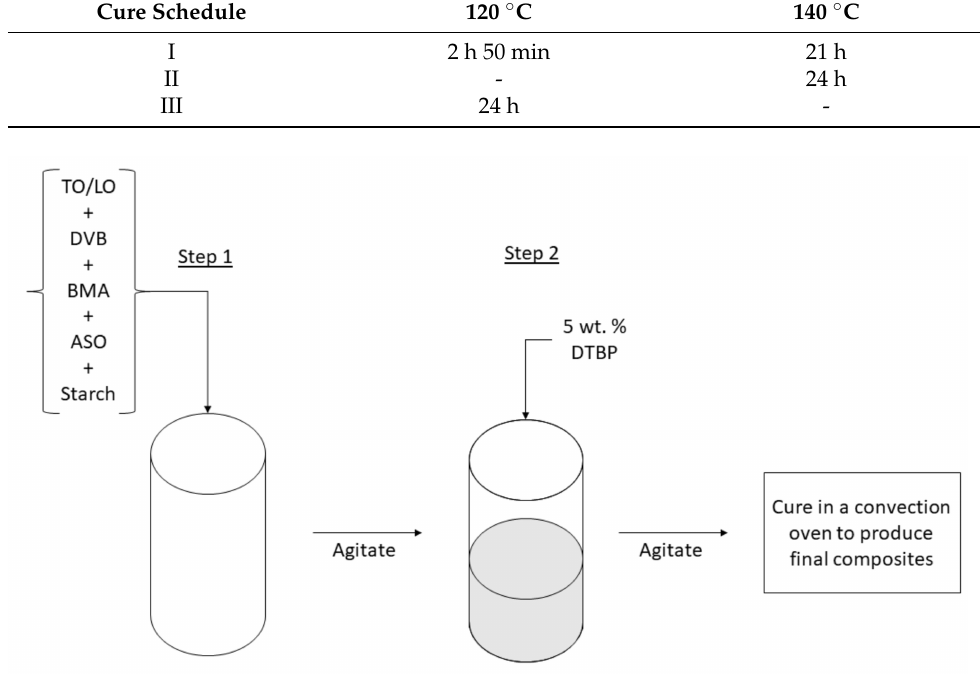
Table 2. Heating schedules investigated.